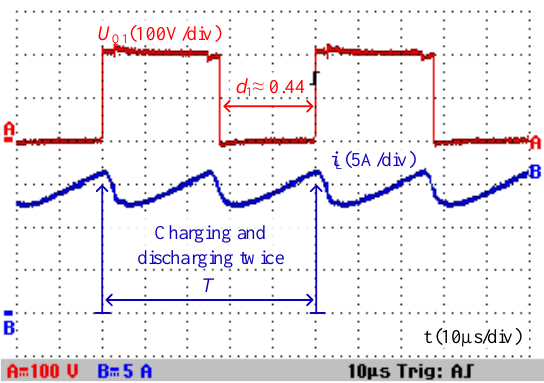
Figure 11. PWM voltage of power semiconductor Q 1 and inductor current i L .